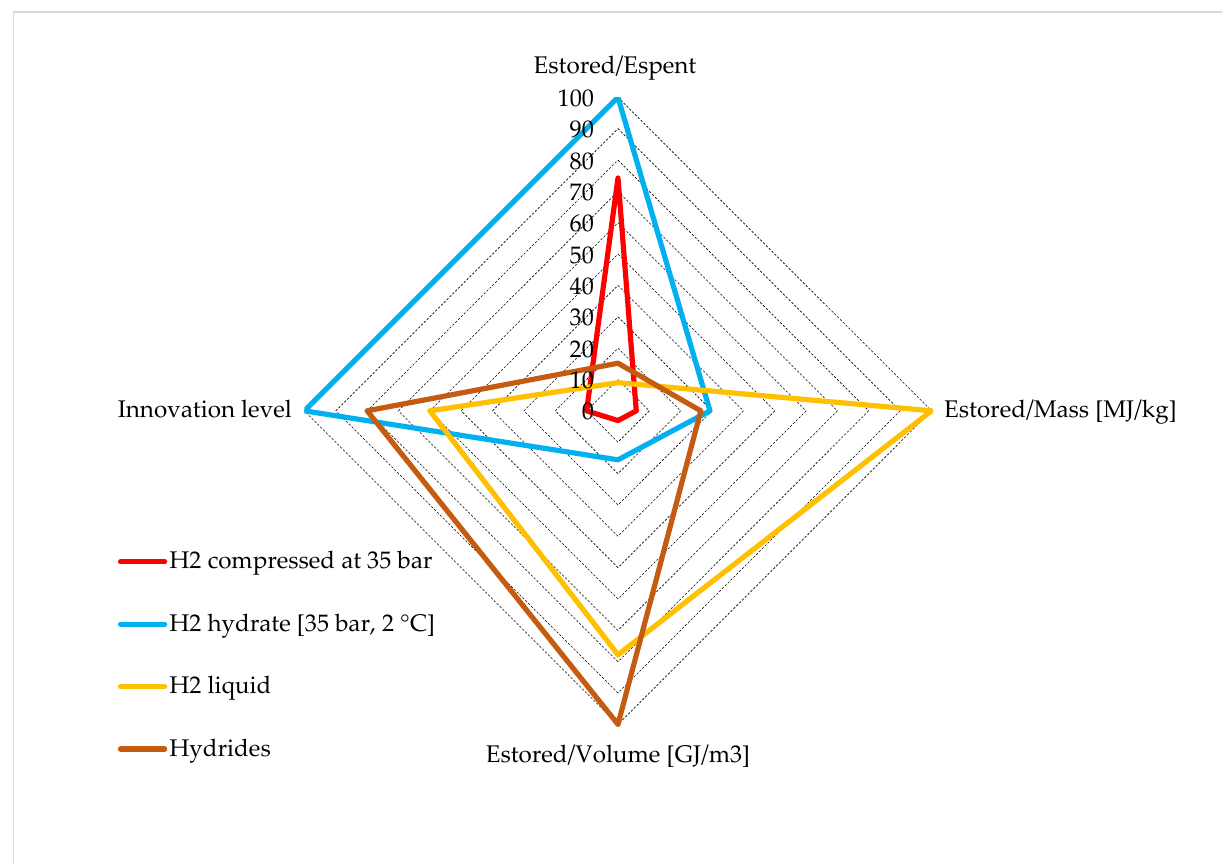
Figure 5. Expected collocation of the proposed strategy in the actual H 2 -storage scenario (the diagram was defined by considering the numerical information provided within the text and reported in the scientific production included in the bibliography).